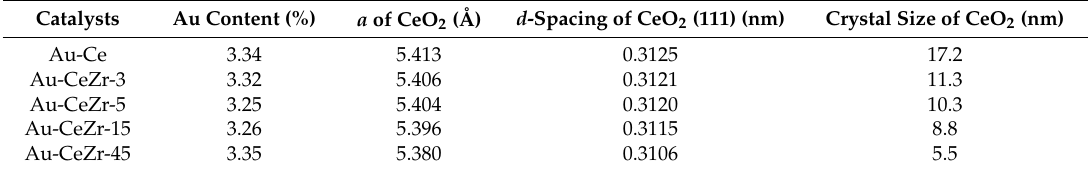
Figure 2. X-ray diffraction patterns of various Au-CeO 2 -ZrO 2 catalysts ( a , b ); CO conversion at 250 °C (%) vs. cell parameter ( a ) of CeO 2 (Å) ( c ) and microstrain (%) ( d ). Table 1. Physical properties and microstructural parameters of Au/ceria-zirconia catalysts. Catalysts